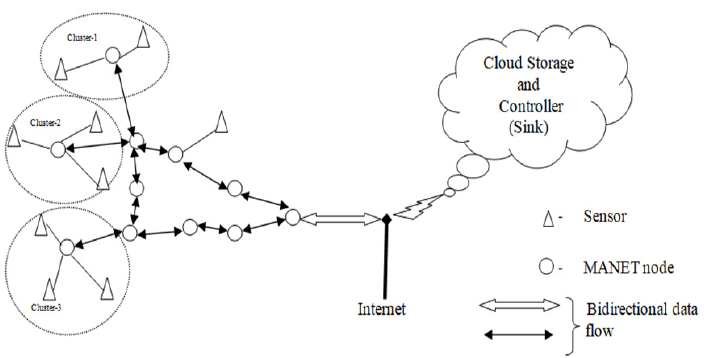
Figure 1. Heterogeneous Network Constructed by Sensor, MANET and Cloud storage through the Internet.